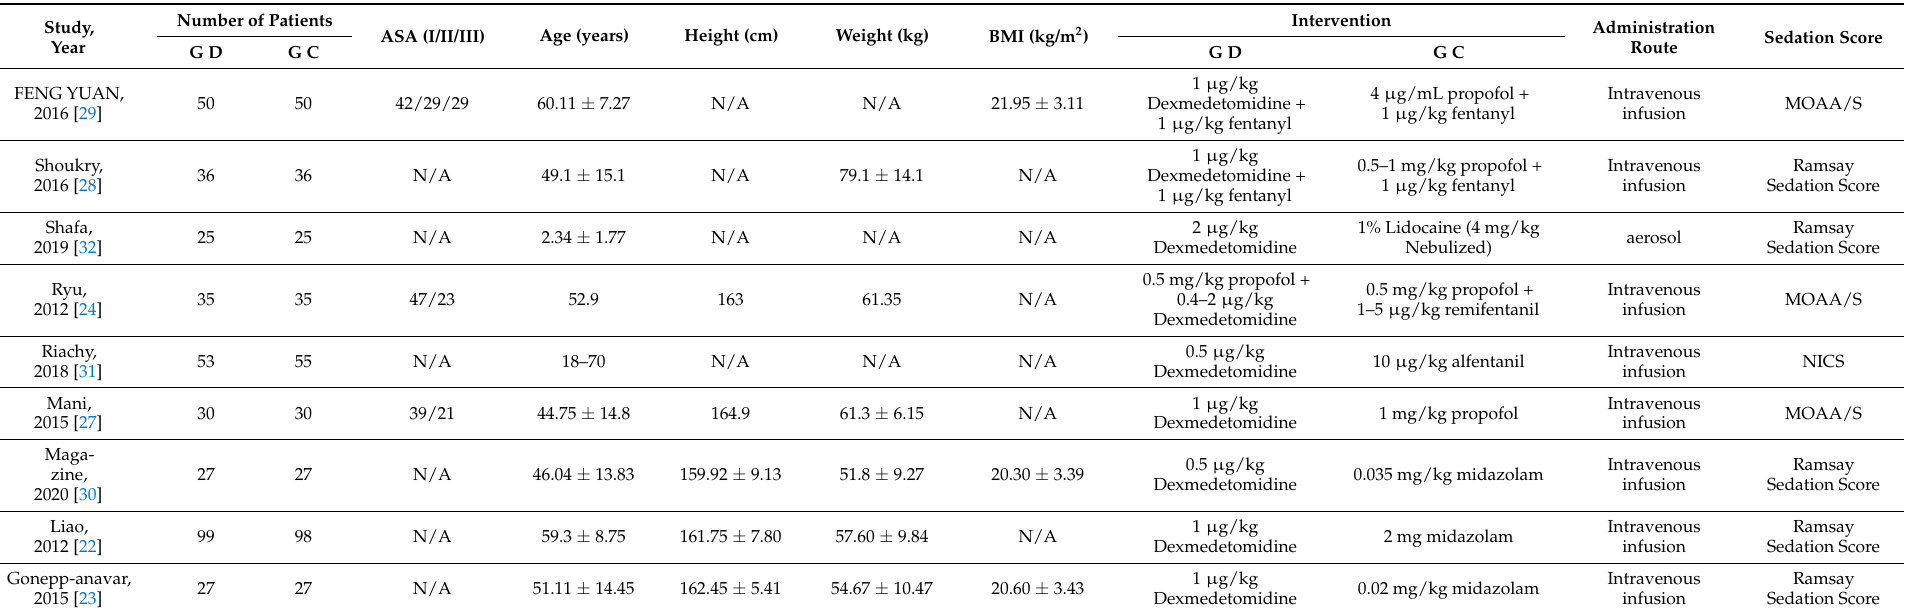
Table 2. Basic characteristics of the included